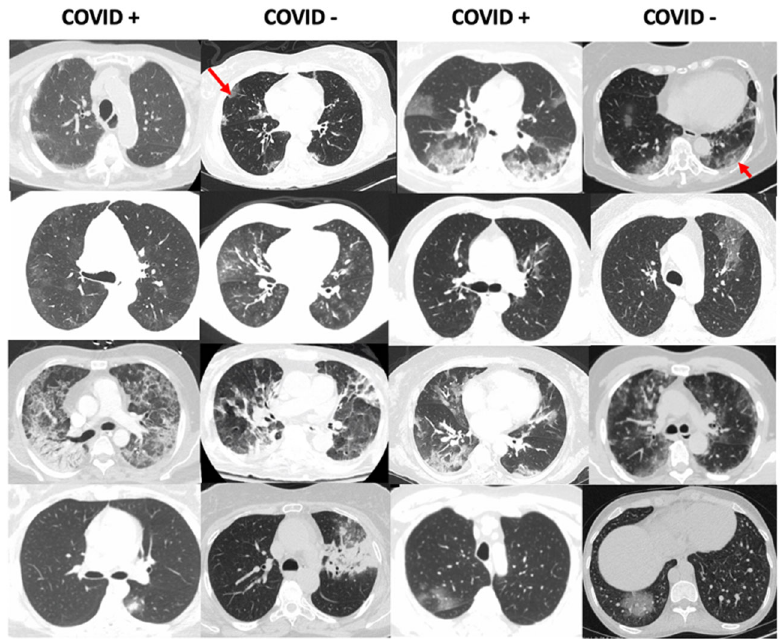
Fig. 13 Examples of COVID − PNA patients in our study that show heterogeneous features, some that are similar to COVID + PNA. For example, two COVID − patients with in fl uenza PNA (red arrows), including H1N1 (long red arrow), show peripheral ground glass opacities similar to COVID +